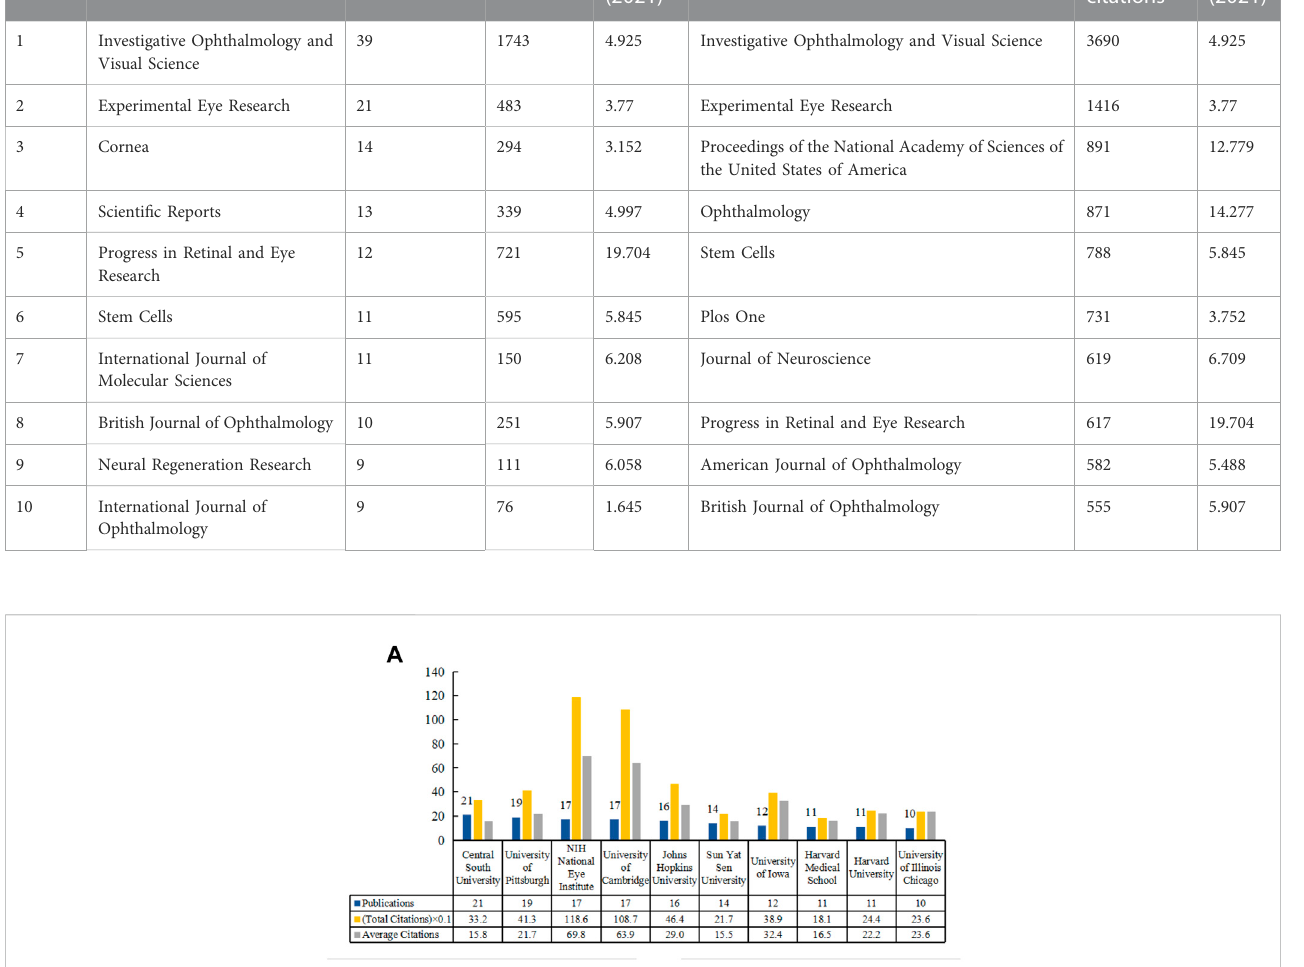
Frontiers in Cell and Developmental